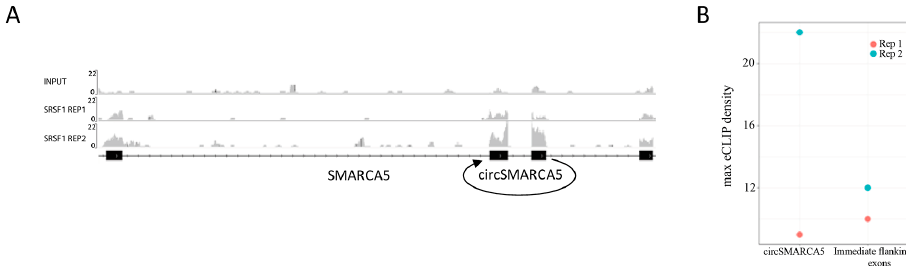
Figure 4. SRFS1 eCLIP data from ENCODE on K562 cells. ( A ) eCLIP read density within the SMARCA5 gene locus (chr4:144461450-144466050, hg19), containing the circSMARCA5 and the